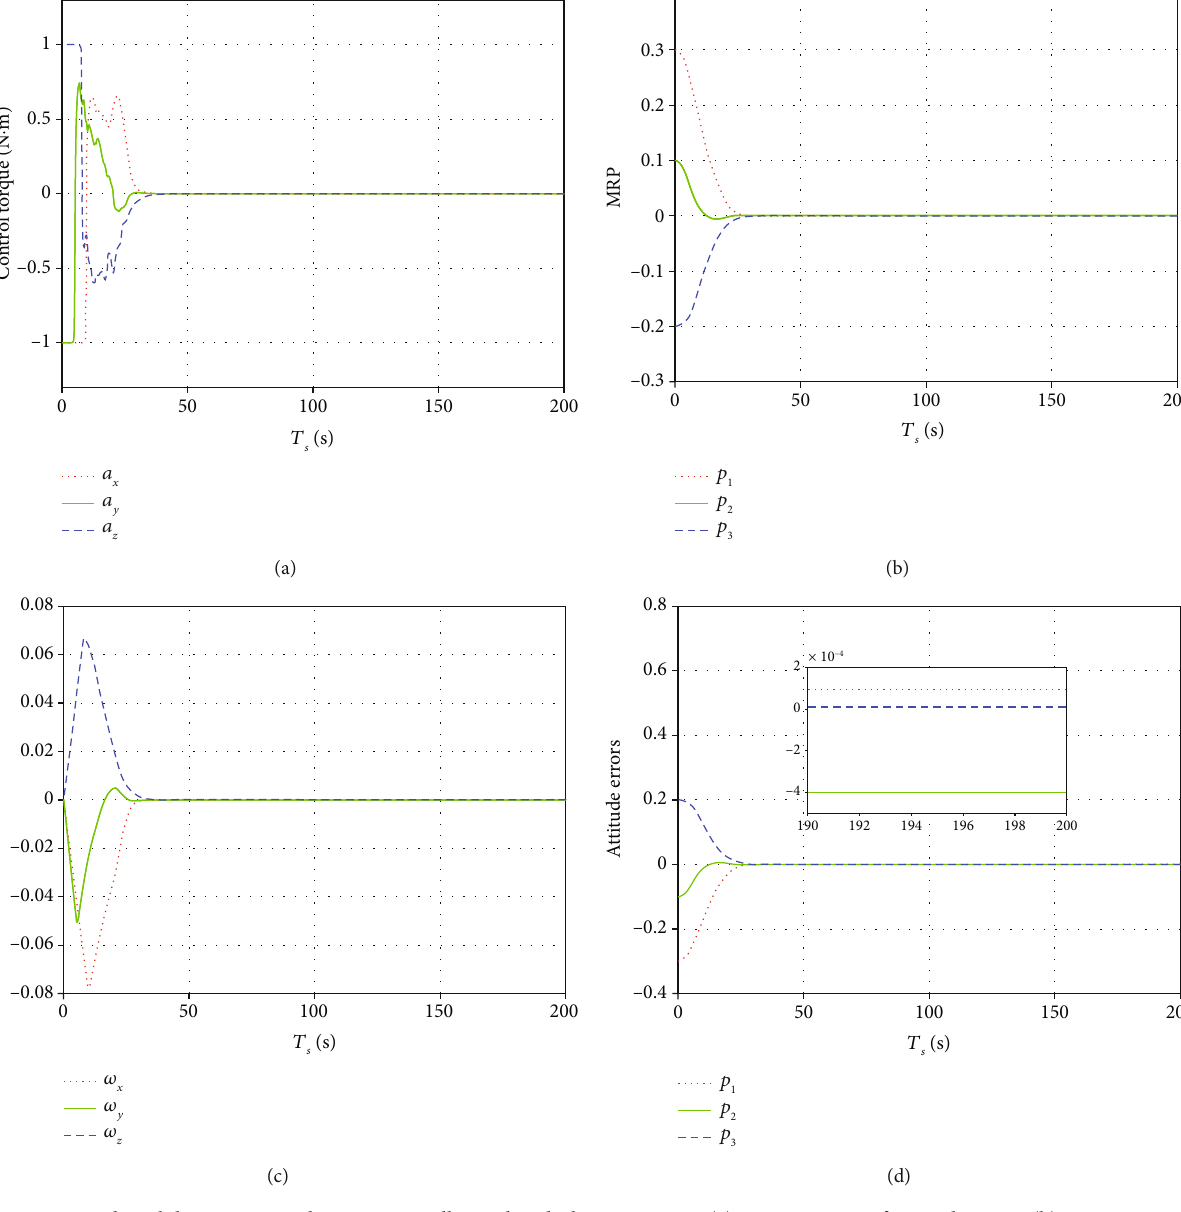
Figure 5: Attitude stabilization using the DRL controller under ideal environment: (a) time response of control torque; (b) time response of MRP; (c) time response of angular velocity; (d) the attitude error